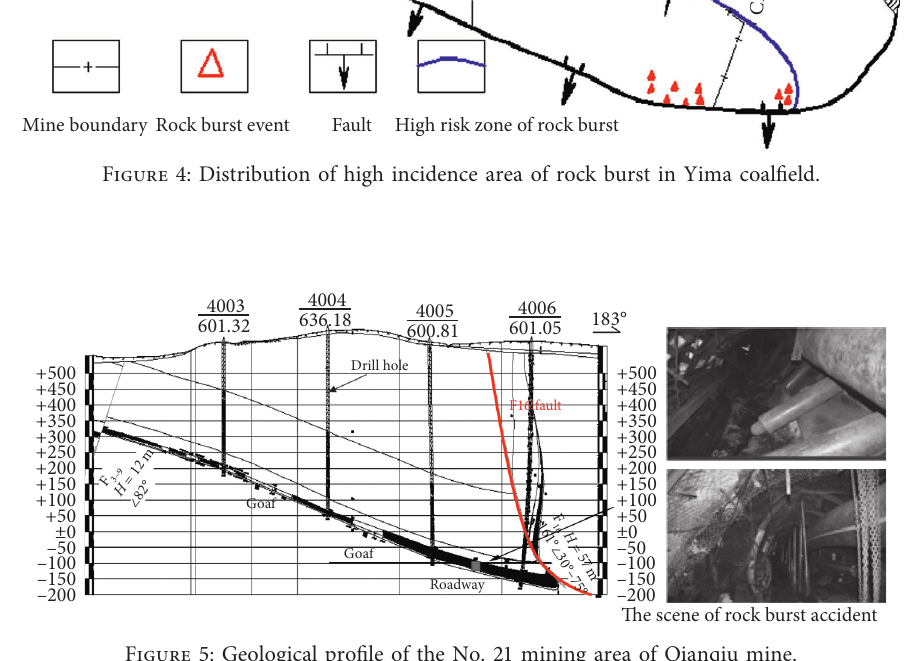
Figure 5: Geological profile of the No. 21 mining area of Qianqiu mine.